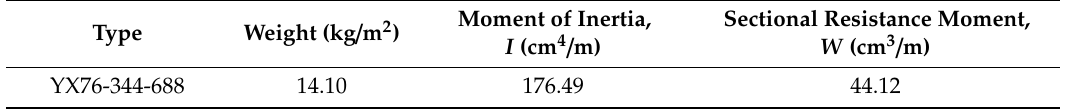
Table 2. Section properties of profiled steel sheeting.